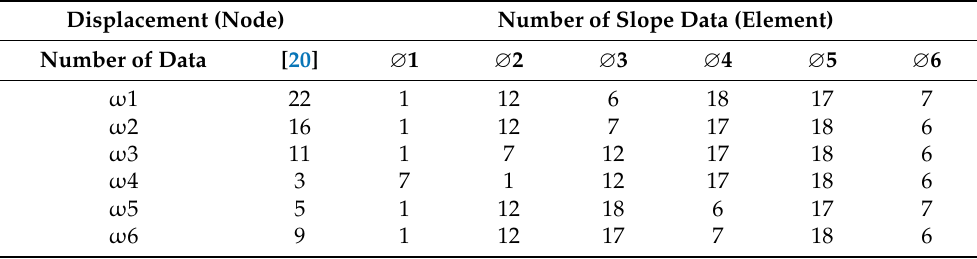
Table 8. Sensor location in the FEM model used for estimation (slope with